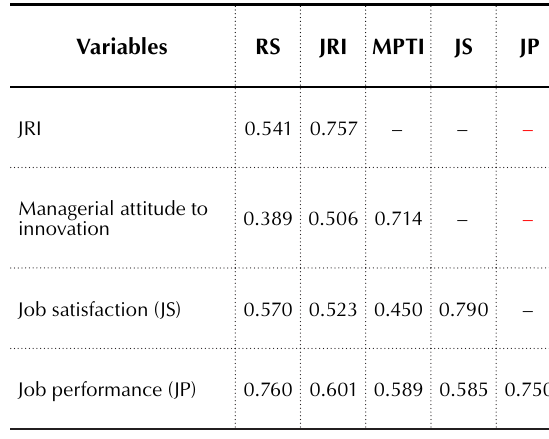
Table 4. Fornell-Larcker Correlation